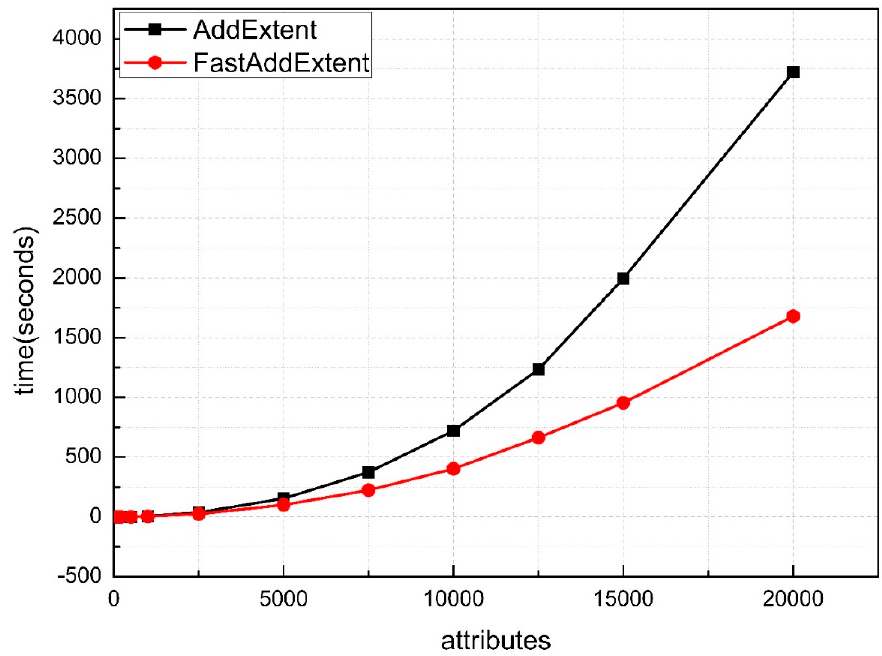
Figure 4. Results for random datasets with low density.